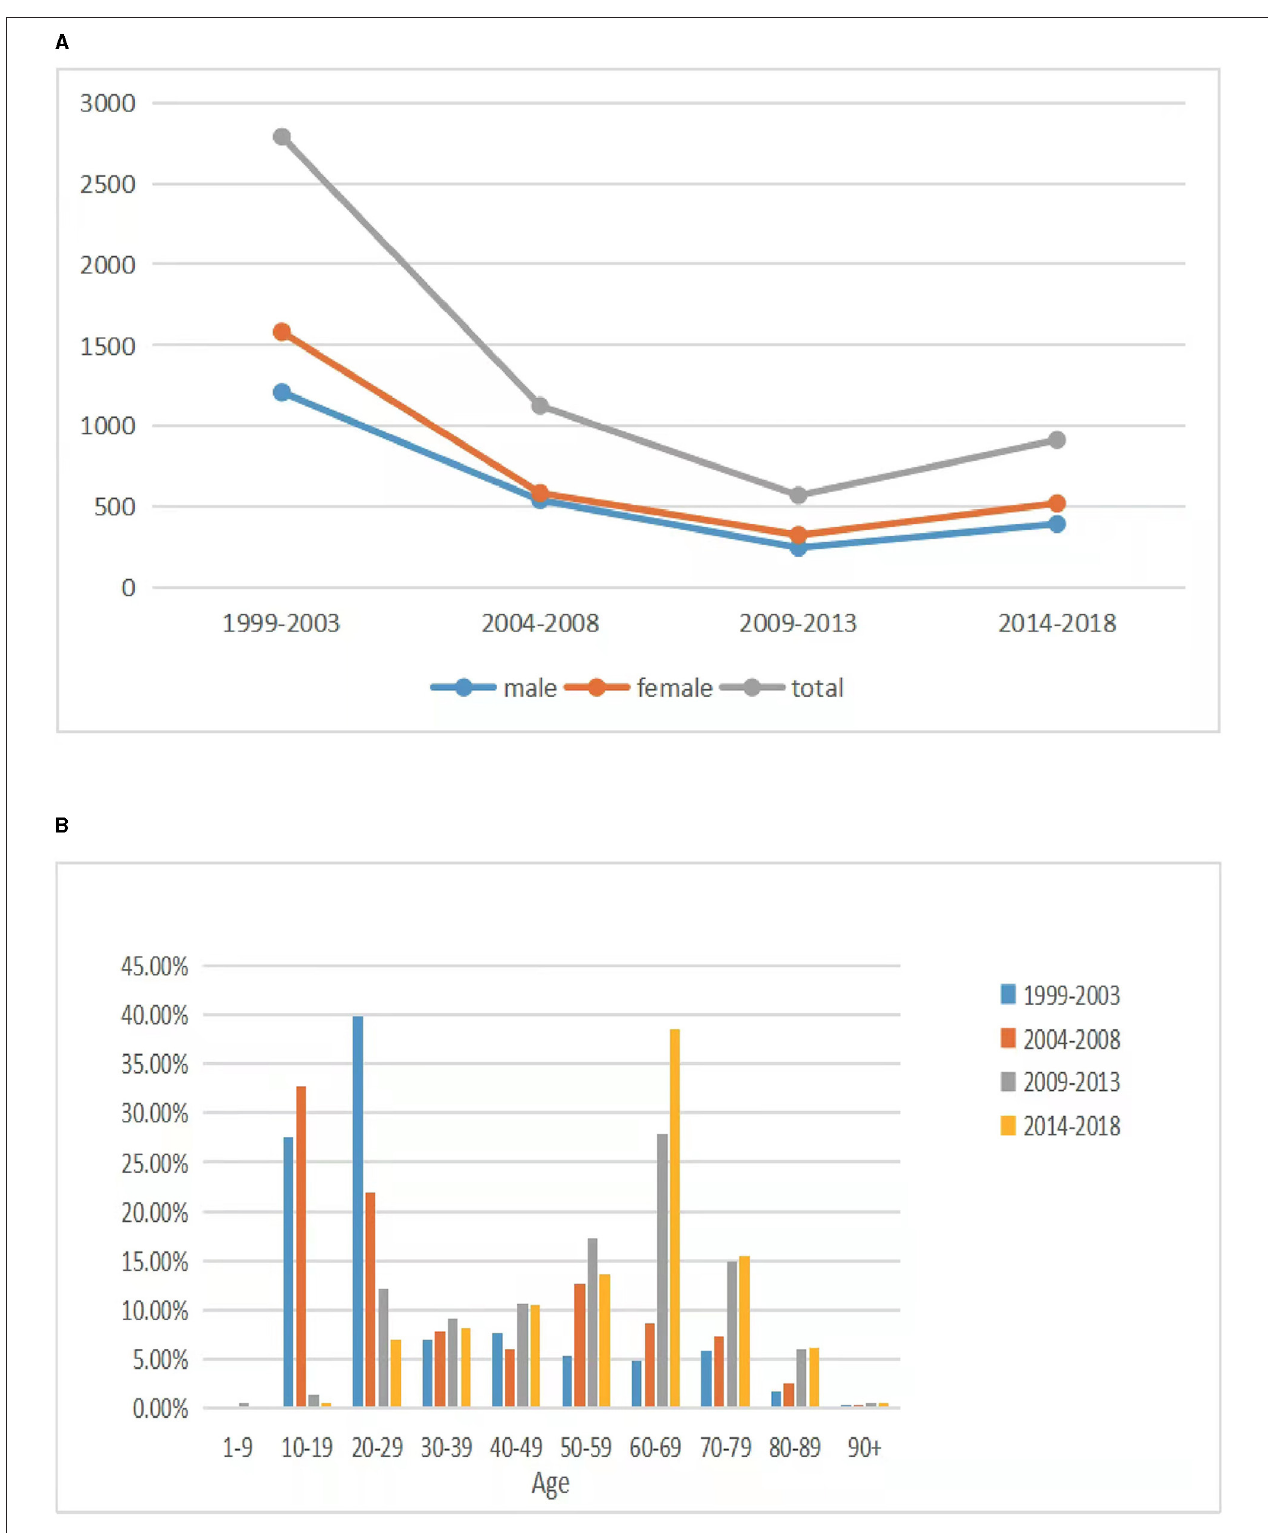
FIGURE 1 | Preregistered voluntary donors in each period. (A) The trend in the numbers of preregistered donors and the sex ratio in each period. (B) Age distribution of the preregistered donors.